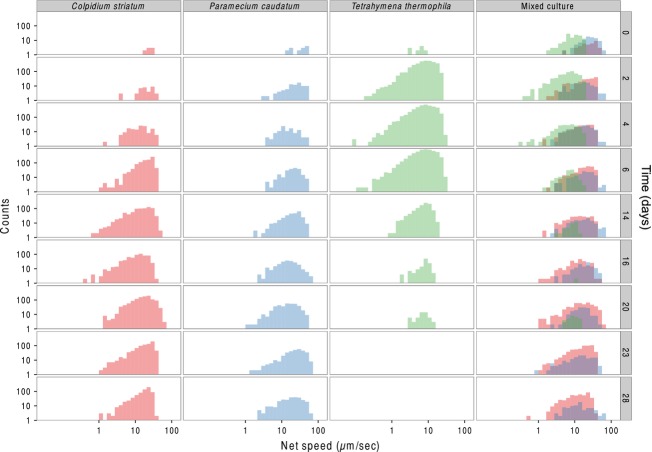
Changes in movement speed through time (from first row to last row) in the mono- and mixed cultures during the experiment. At day 20, the medium was partly replaced by fresh medium perturbing the mono- and mixed cultures. Both axes are on log10 scaling.